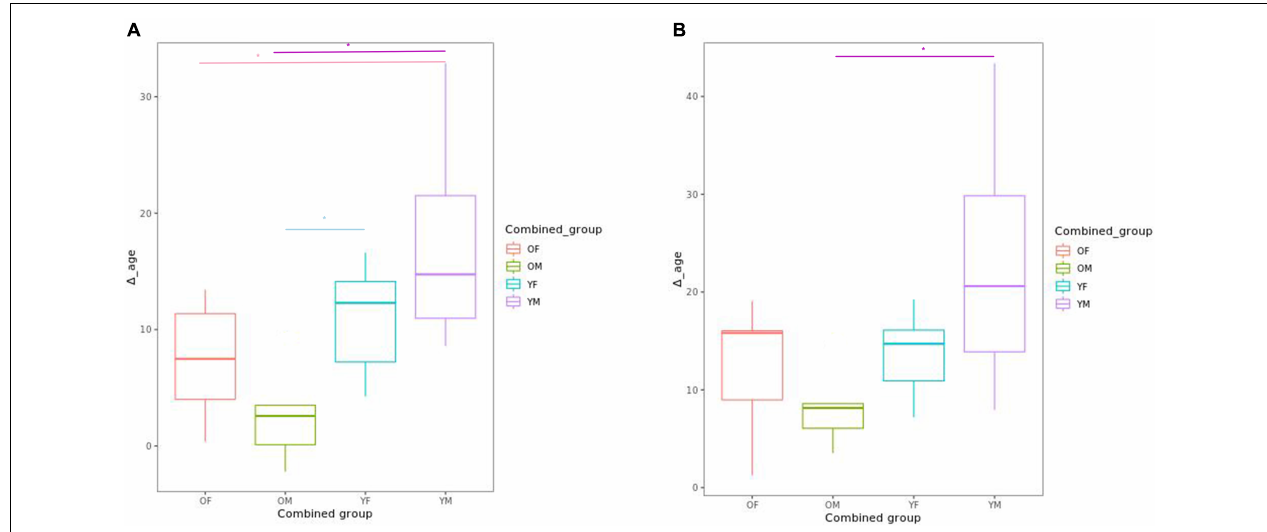
FIGURE 3 | Box plot showing the comparison of delta age ( (cid:49) age) using (A) Hannum’s clock and (B) Horvath’s clock in the four groups generated according to the mean values of chronological age and years of CLZ treatment. Differences are observed between young patients with more or a few years of treatment vs. older patients with many years of treatment. The four groups analyzed were: young patients with few years of treatment (YF); young patients with many years of treatment (YM); older patients with few years of treatment (OF), and older patients with many years of treatment (OM). The asterisk ( ∗ ) denotes significant differences.